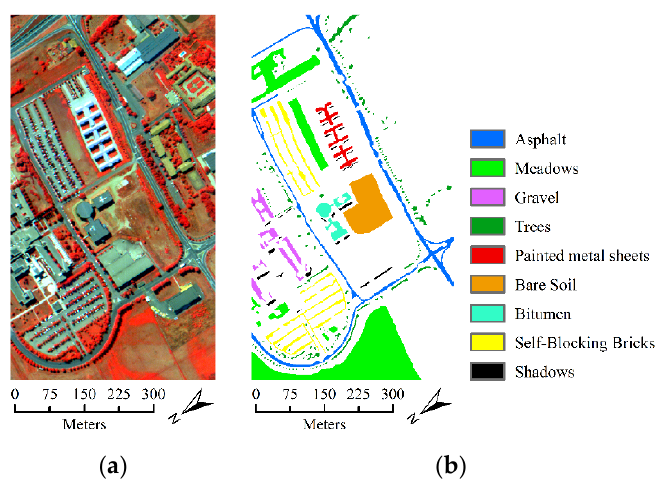
Figure 6. ( a ) The false color composition image of Pavia University dataset; and, ( b ) the ground truth map of Pavia University dataset.